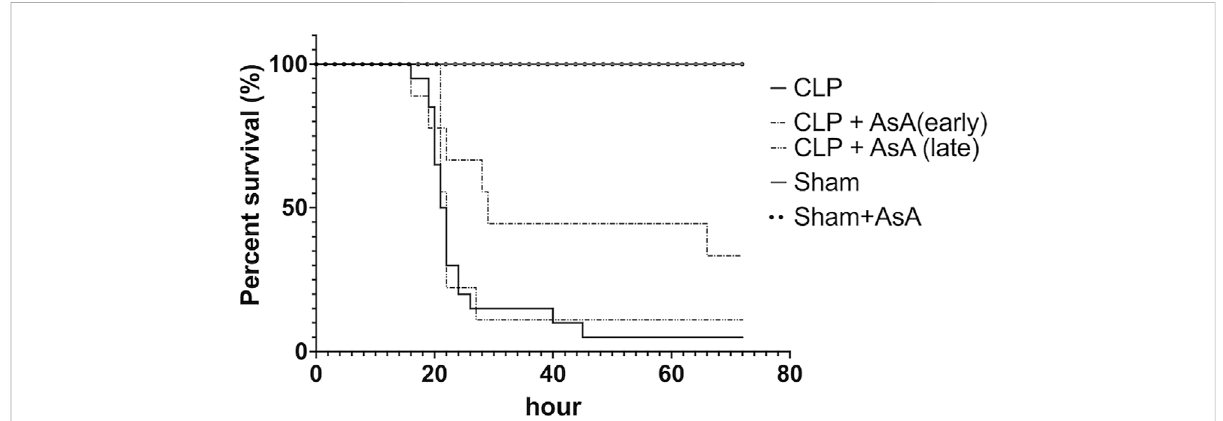
FIGURE 2 Mice subjected to CLP, as described in the Methods section, for 72 h survival study. In the CLP + AsA (early) group, AsA was injected subcutaneously immediately after the operation ( n = 9). In the CLP + AsA (late) group, AsA was injected subcutaneously 12 h after the operation ( n = 9).The groupthat had notreceived AsAwasgiven thesameamountofNSneeded todissolve theAsA intheAsAgroup. Although thetiming ofsaline administration in the CLP group differed between the late and early groups, they were compared with the other groups as the same group becausetheseverityofthediseasedidnotchange.TheCLP+AsA(early)micegrouphadasigni fi cantlyprolonged survivalratecomparedtotheCLP group.* p < 0.05versusCLP.CLP+AsA(late)miceshowednodifferenceinthesurvivalratefromtheCLPgroup.* p < 0.05versusCLP.Abbreviations: AsA, ascorbic acid; CLP, cecal ligation and